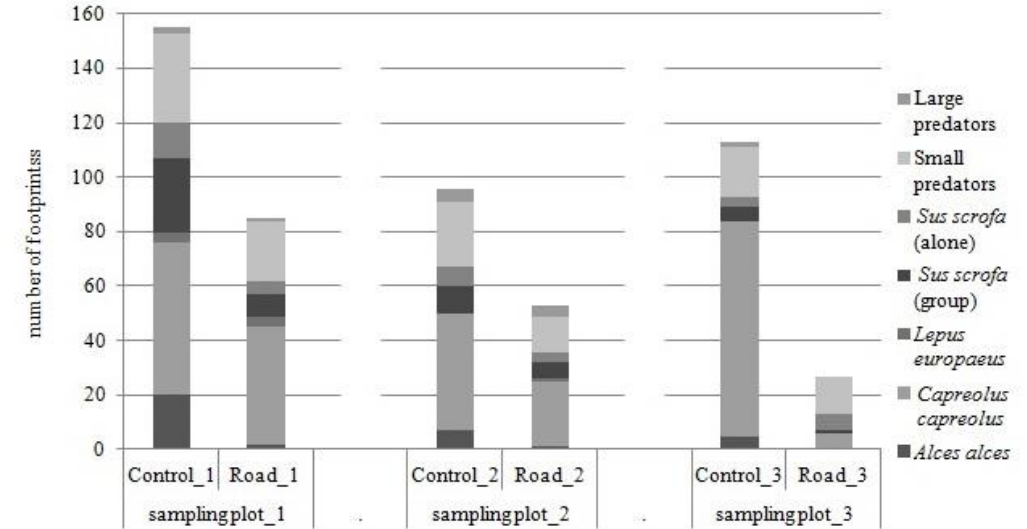
Fig. 3. Animal-footprint observation over the years and observation